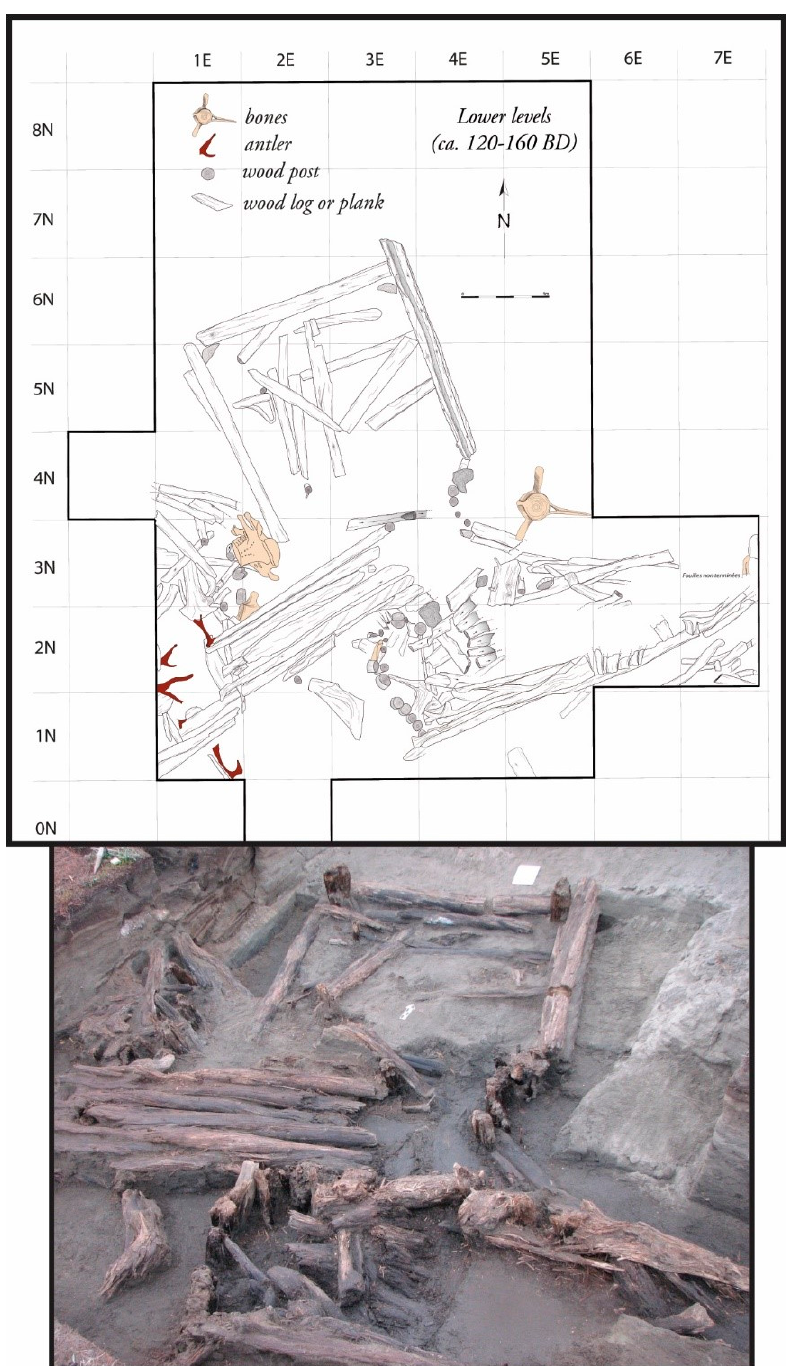
Figure 10. Feature 12 at Cape Espenberg KTZ304 site. Excavated area in 2011 to the west of the surveyed area shown in Figure 9. Depth excavated is 0.9 to 1.2 m below surface (map by Sylvie Elies and Claire Alix and photo by Claire Alix). Frozen material was encountered at depths consistent with the GPR estimates. The layout and complexity of deposits was also consistent with the GPR results shown in Figures 9 and 10, which is immediately east of the Feature 12 excavation unit.